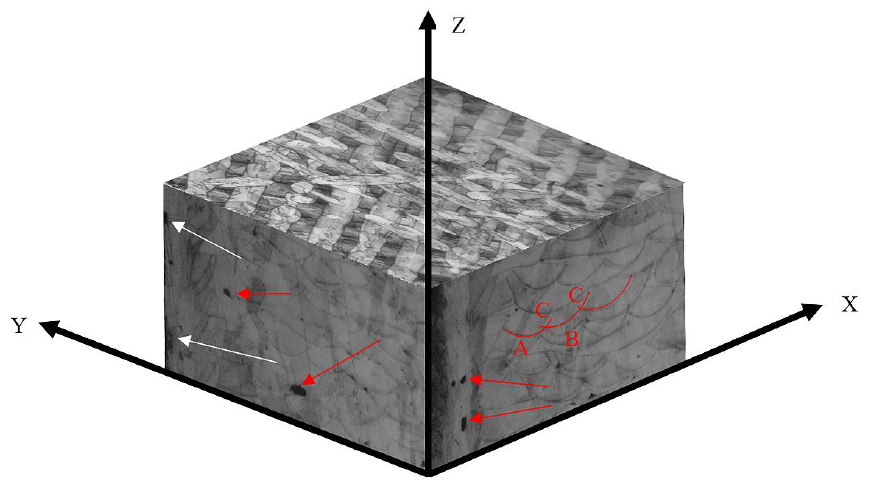
Figure 5. Organization of the porous bone scaffolds.